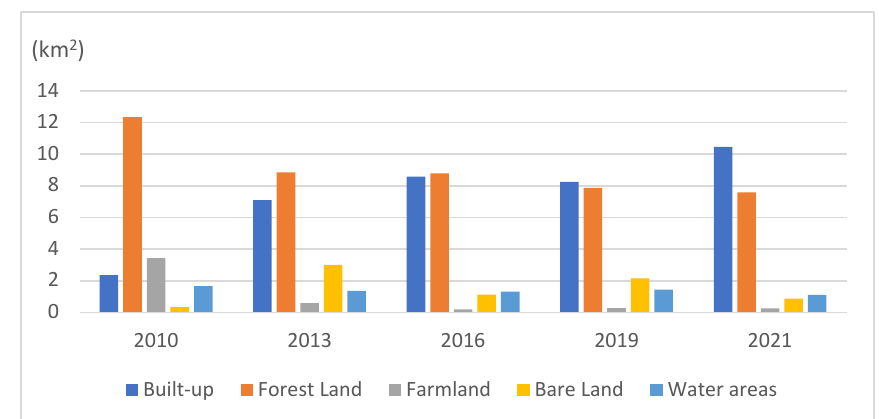
Figure 4. Land classification results for 2010–2021.